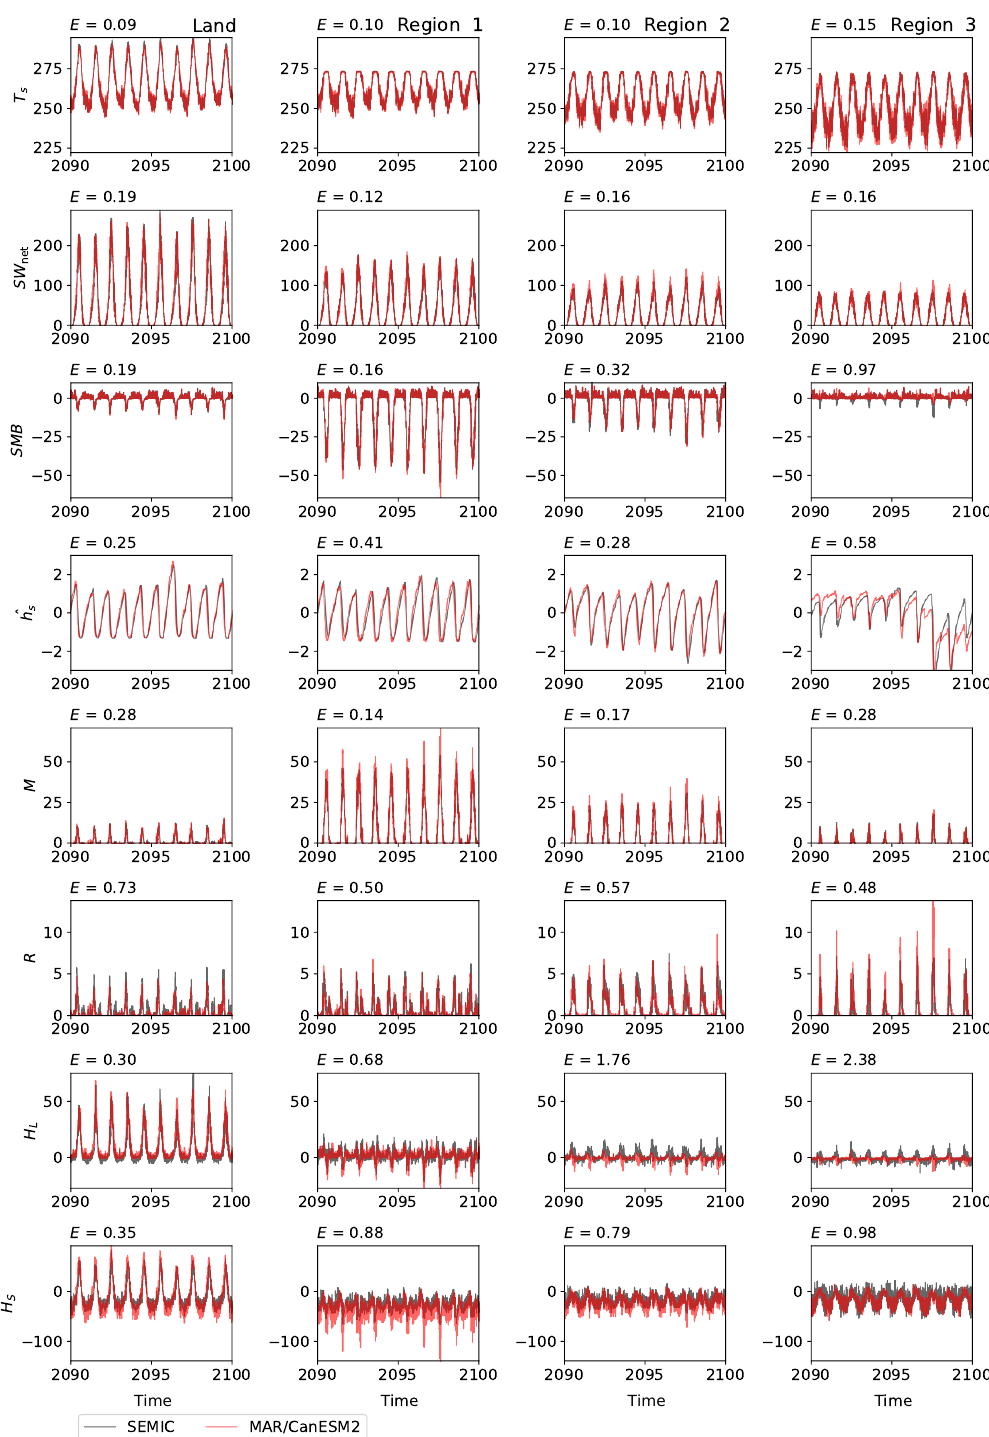
Figure 6. Time series of ice sheet averaged surface temperature T s (K), net shortwave radiation SW net (Wm − 2 ), surface mass balance SMB (mmday − 1 ), standardised snow height ˆ h s , surface melt M (mmday − 1 ), refreezing R (mmday − 1 ), latent heat flux H L (Wm − 2 ), and sensible heat flux H S (Wm − 2 ) as calculated by MAR and by SEMIC with optimal parameters from Table 3 for the years 2090–2099 of the historical period. Note that h s is scaled via its standard deviation because SEMIC and MAR incorporate a different criterion of maximum snow height (5m in SEMIC; more than 10m in MAR). The annotated number on the top left of each frame is the computed centred root mean square error as defined in Eq. (19), and it marks the distance to the reference field as shown in the Taylor diagram Fig.